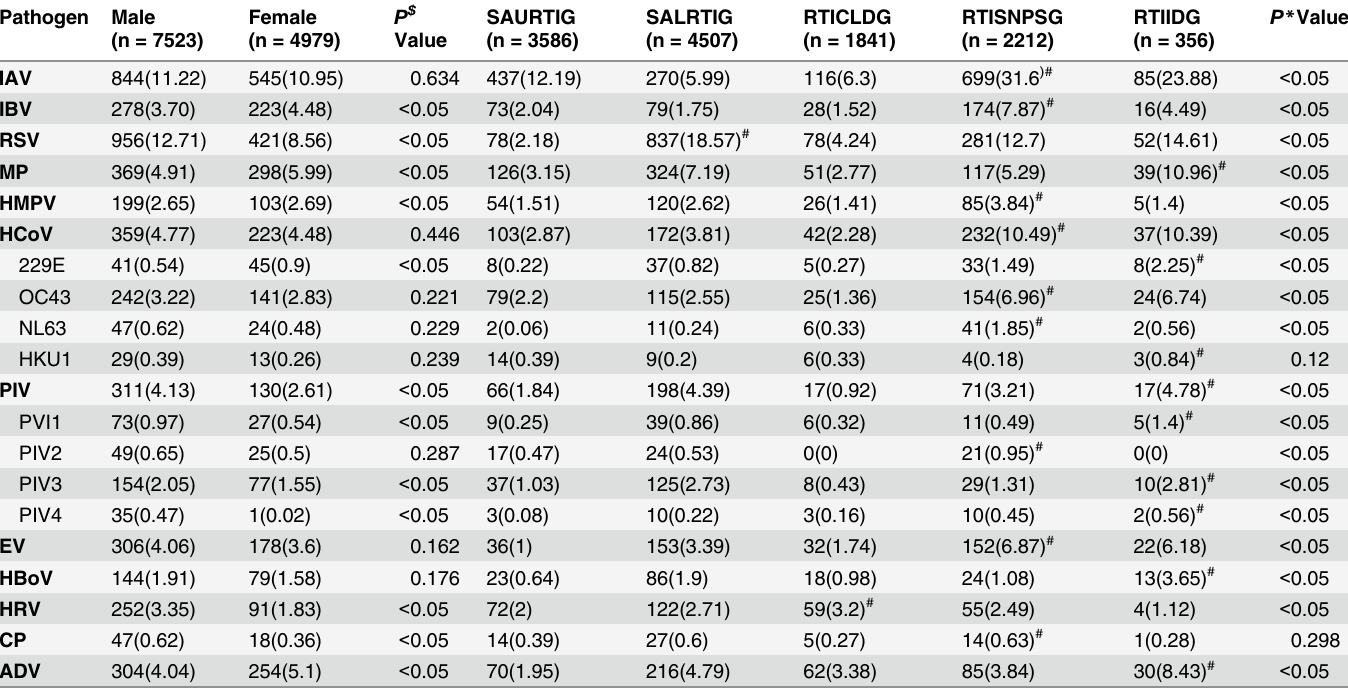
Table 2. The prevalence of different respiratory pathogens from July 2009 to June 2014.